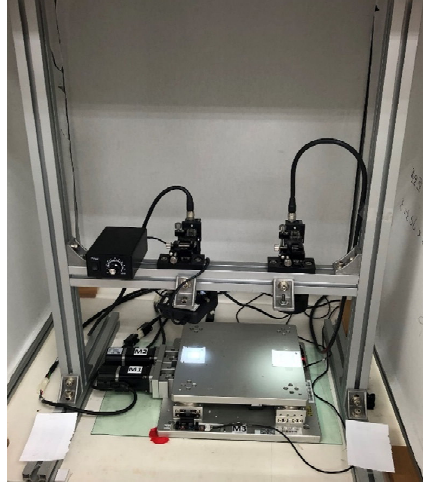
Figure 3. Photograph of the XXY experimental stage.